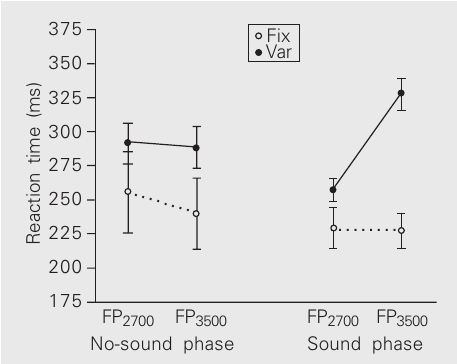
Figure 1. Reaction times of group fix (G Fix ) and group var (G Var ) in the no-sound and sound phases of the second testing session of Experiment 1a. For G Fix the accessory stimulus always preceded the target stimulus by 200 ms. For G Var the accessory stimulus sometimes preceded the tar- get stimulus by 200 ms and sometimes preceded it by 1000 ms. FP 2700 and FP 3500 refer to the interval between the appearance of the fixation point and the appearance of the target stimulus. Data are reported as means ± SEM for 6 volunteers in each